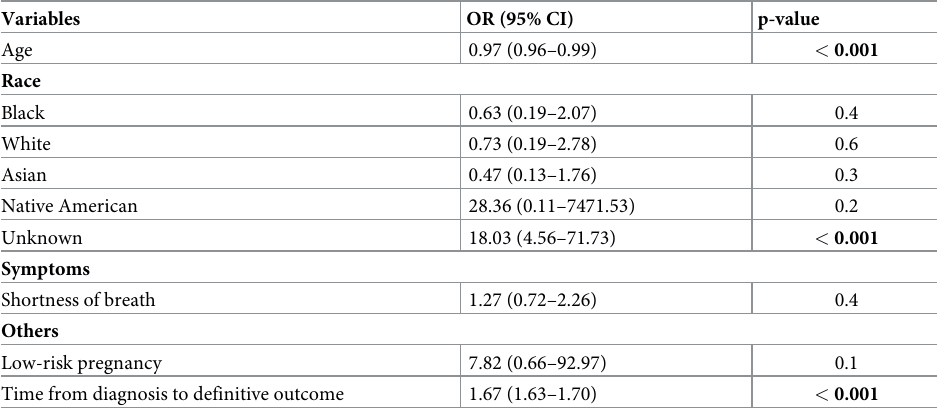
Table 4. Risk factors associated with the length of hospital stay for hospitalized COVID-19 patients. Variables